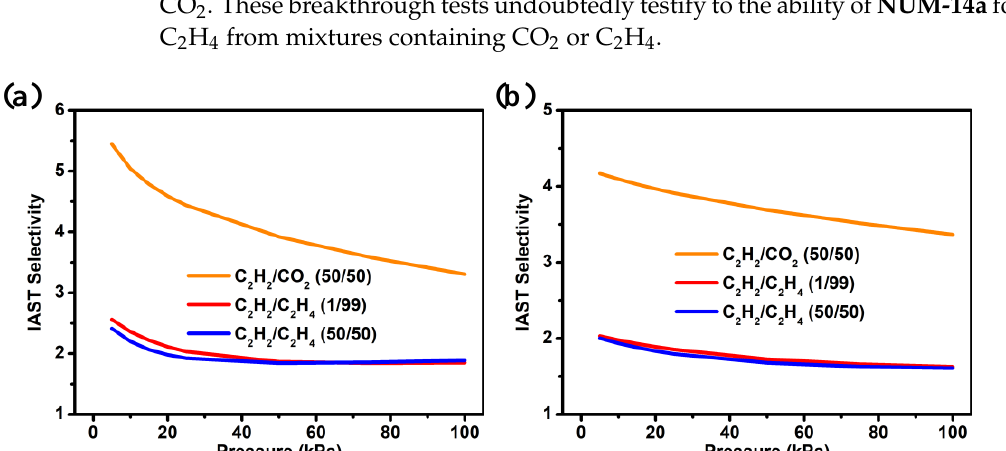
Figure 3. ( a ) The adsorption selectivities of NUM-14a , predicted from IAST for C 2 H 2 /CO 2 (50:50, v / v ), C 2 H 2 /C 2 H 4 (1:99, v / v ) and C 2 H 2 /C 2 H 4 (50:50, v / v ) at 273 K ( a ) and 298 K ( b ).